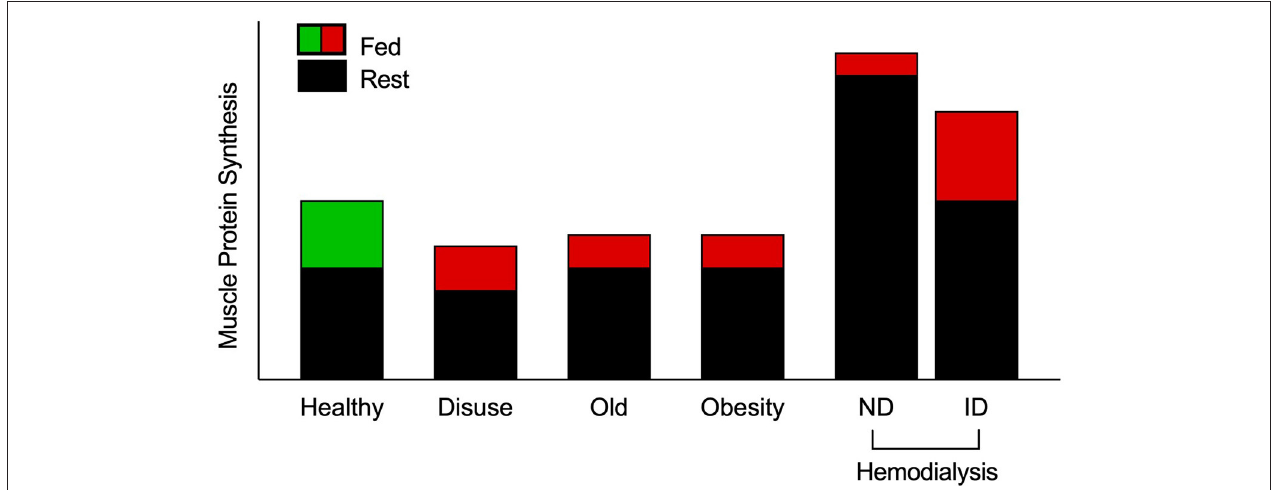
FIGURE 1 | Schematic of muscle protein synthesis rates (MPS) in the basal and postprandial states. Eating a protein meal generally results in a ∼ 2-fold increase in the stimulation of postprandial MPS from basal in healthy muscle. However, a reduced responsiveness of postprandial MPS, or anabolic resistance, to elevated plasma amino acid availability has been detected in older, obese, and adults on maintenance hemodialysis (MHD) ( 3, 4, 9–13). Muscle disuse is also a common facilitator of anabolic resistance. Hemodialysis patients have been studied on both dialysis and non-dialysis days. Despite peak inflammation (and presumably catabolism) during dialysis, MPS has been shown to be responsive to intravenous elevation of amino acid availability. However, skeletal muscle is overstimulated in the post-absorptive state on a non-dialysis day, which is associated with inflammation and uremic toxins, to induce overt anabolic resistance. Green indicates “healthy” fed-state MPS response, red indicates anabolically resistant fed-state MPS response. ND, non-dialysis day; ID,